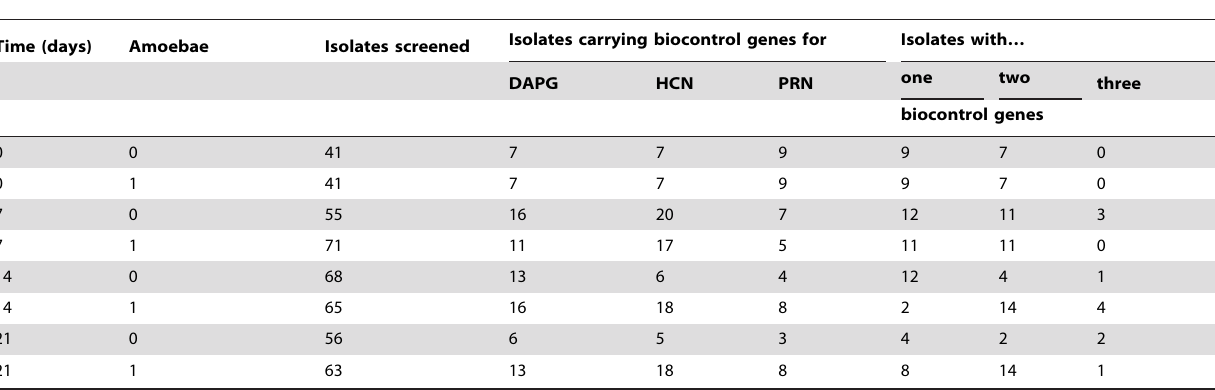
Table 2. Number of screened bacterial isolates carrying biocontrol genes in the microcosm experiment with barley.